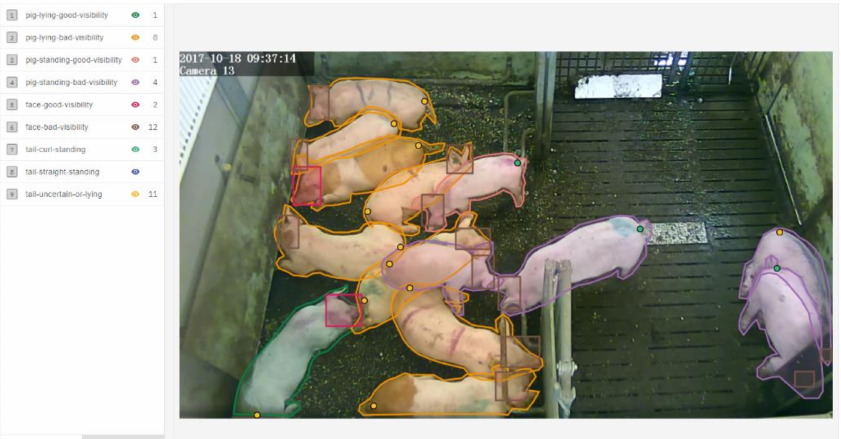
Figure 2. Image labelling overview in the Labelbox annotation tool.